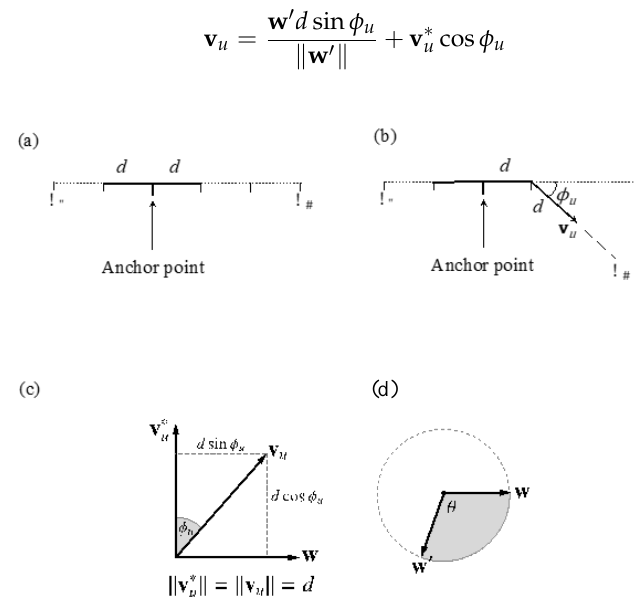
Figure 3. Graphical representation of the sampling process for step vectors, v u . ( a ) From the voxel corresponding to the anchor point, the “left” and “right” tract lengths are sampled from the model length distributions, obtaining the total length of the streamline. ( b ) From the first step on one side, the vector v u is sampled, leading to the next knot in the streamline. This vector is obtained from the angle φ u sampled from the model angle distribution at that knot. This is replicated for every step until the distance L 2 is reached. The process is then repeated for the “left” tract lengths. ( c , d ) Geometric representation of the sub-steps for the sampling of v u : given a reference tract direction, v ∗ u , and an angular deviation from it, φ u ( c ). These jointly specify a circular locus of possible directions ( d ), from which a final vector is chosen by additionally sampling θ ∈ [0, 2 π ].